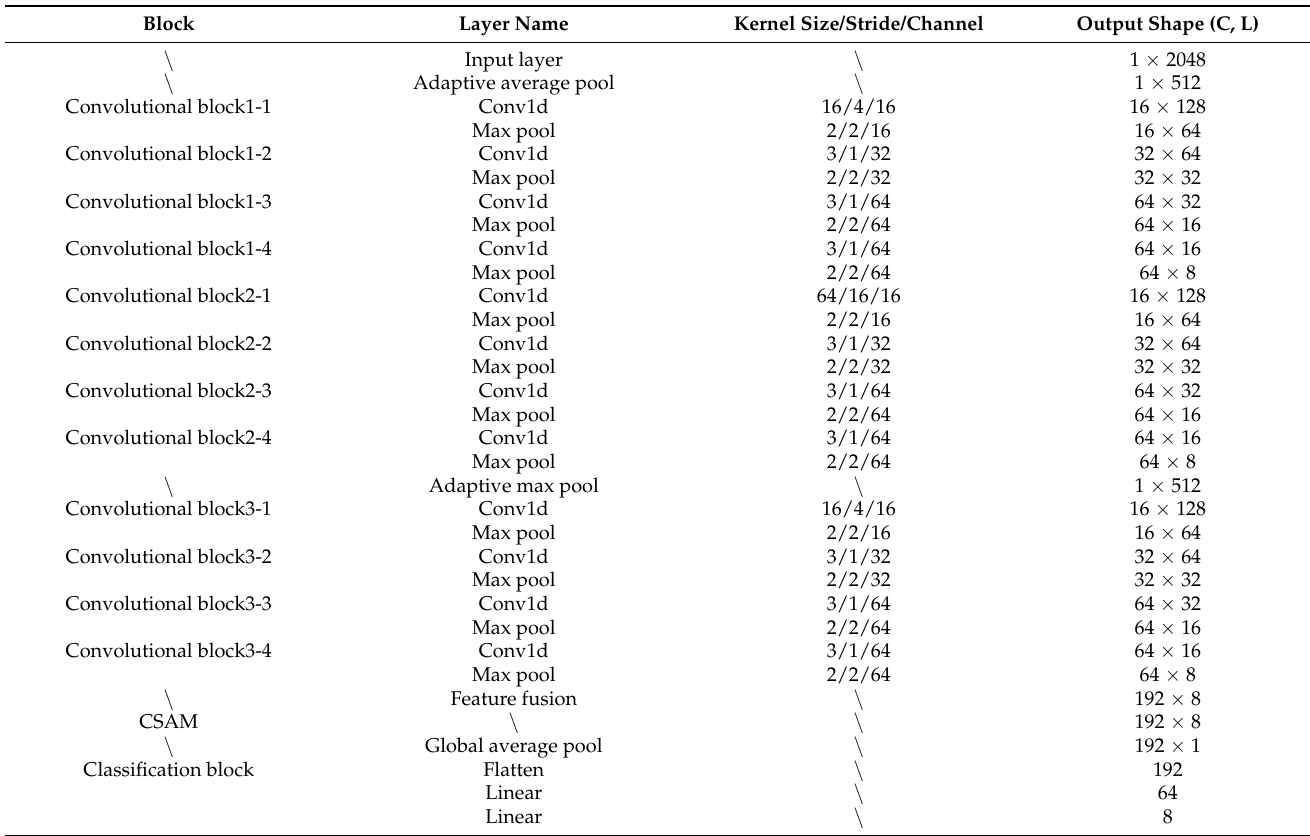
Table 3. Detailed network parameters of the CSAM-MSCNN.